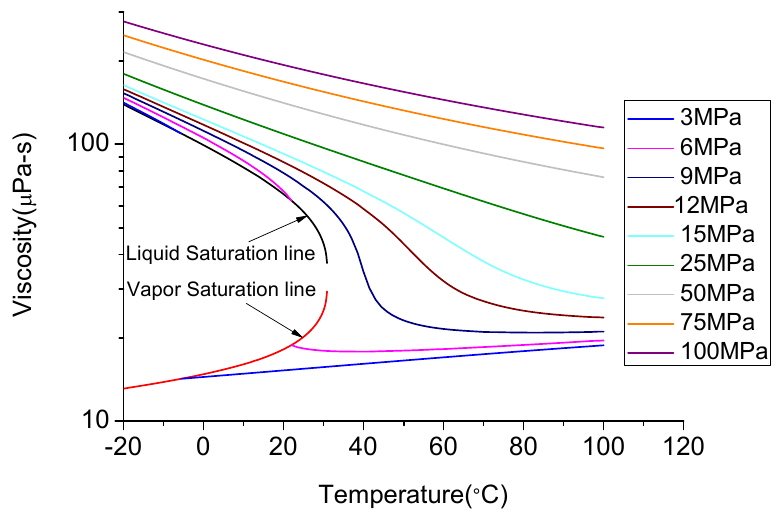
Figure 12 . Viscosity change with temperature and pressure [88].